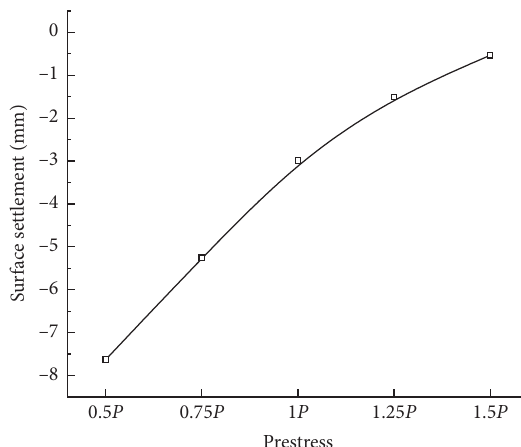
Figure 7: Influence of prestress on maximum ground